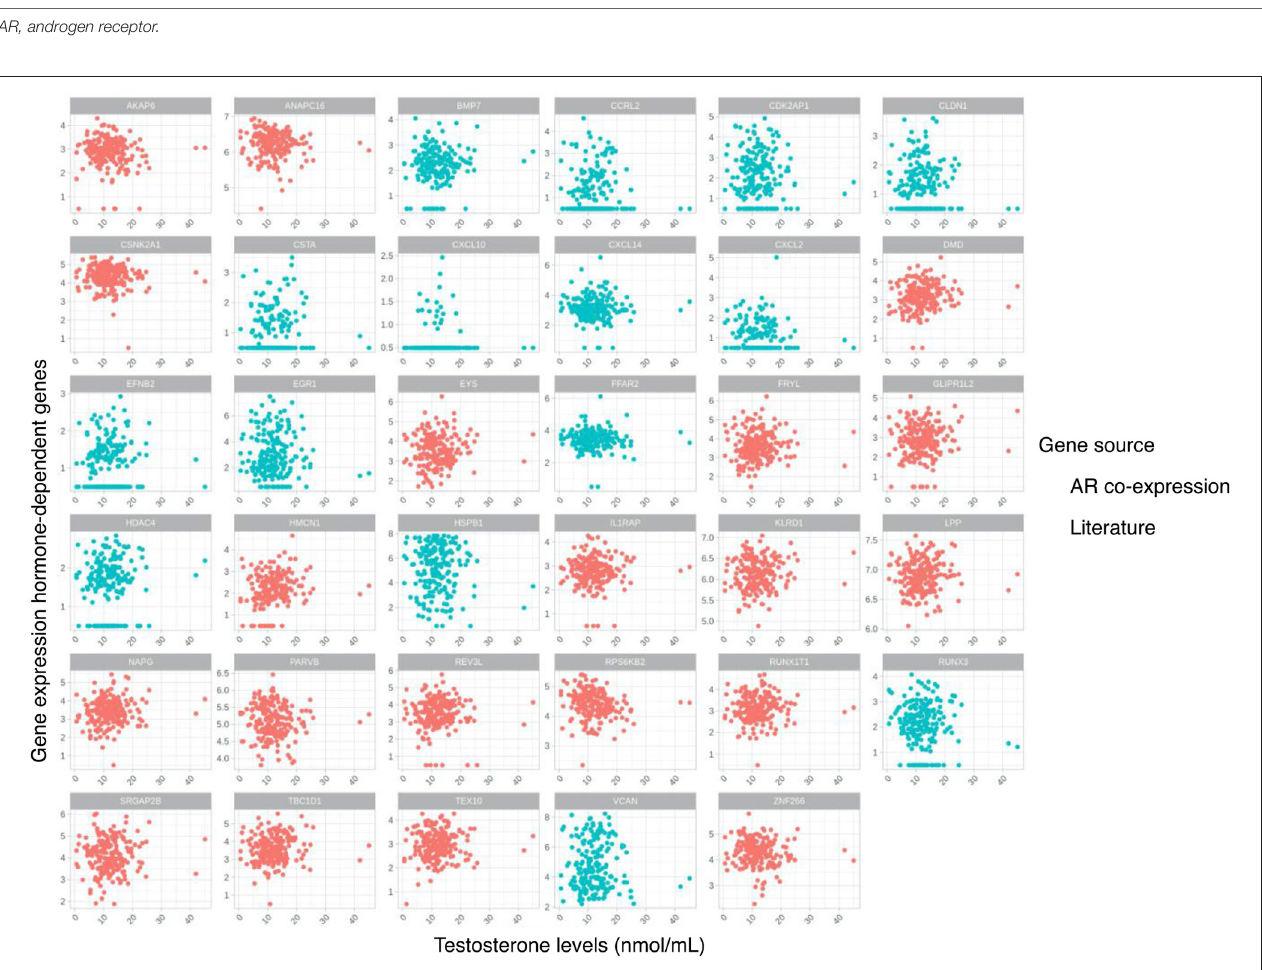
FIGURE 2 | Scatterplots for testosterone levels and gene expression of selected hormone-dependent genes based on literature and gene co-expression with androgen receptor (AR) gene in the atherosclerotic